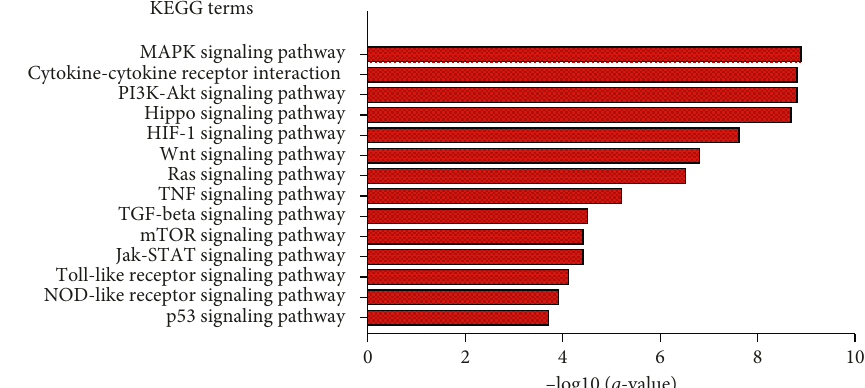
Figure 2: Bioinformatics pathway analysis for cardiac fibrosis-related gene sets with clusterProfiler [29].